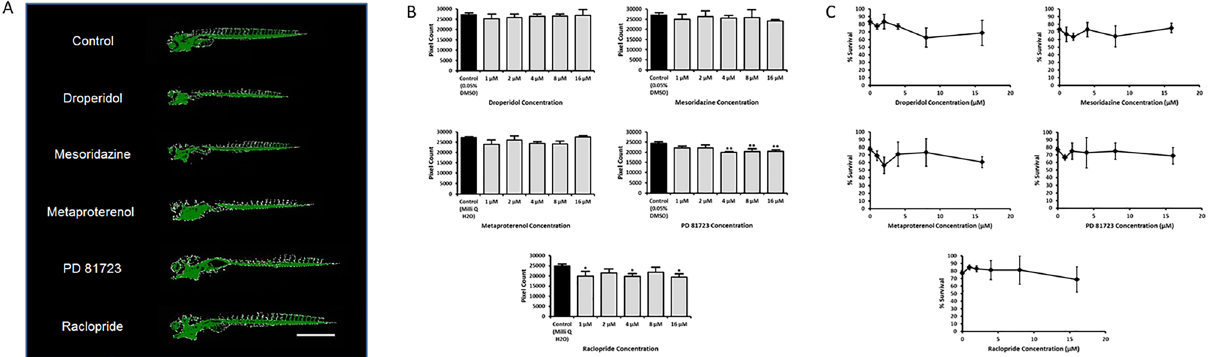
Figure 1. Top 5 hit compounds from a screen of the NIHCCLI&II for angiogenesis inhibitors. ( A ) Representative images of Tg(kdrl:EGFP) zebrafish treated with the top 5 hit compounds . Pixels containing endothelial cells are identified and enhanced with the HTP pixel count readout protocol as previously described 14 . Fish are at 4 dpf. Scale bar is 1 mm. ( B ) Pixel count readout of Tg(kdrl:EGFP) zebrafish treated with various concentrations of the top 5 compounds compared to a negative control. PD 81,723 (4, 8, and 16 µM) and raclopride (1, 4, and 16 µM) yielded significantly (** = P < 0.01 and * = P < 0.05 vs. control) lower pixel counts when compared to the control group. The experiments were repeated in triplicate with an N = 16 for each condition in each experiment. The error bars represent the standard deviation of the means from the three experiments. ( C ) Survival curves. None of the compounds seemed to have a major impact on mortality. The error bars represent the standard deviation of the survival percentage from the three